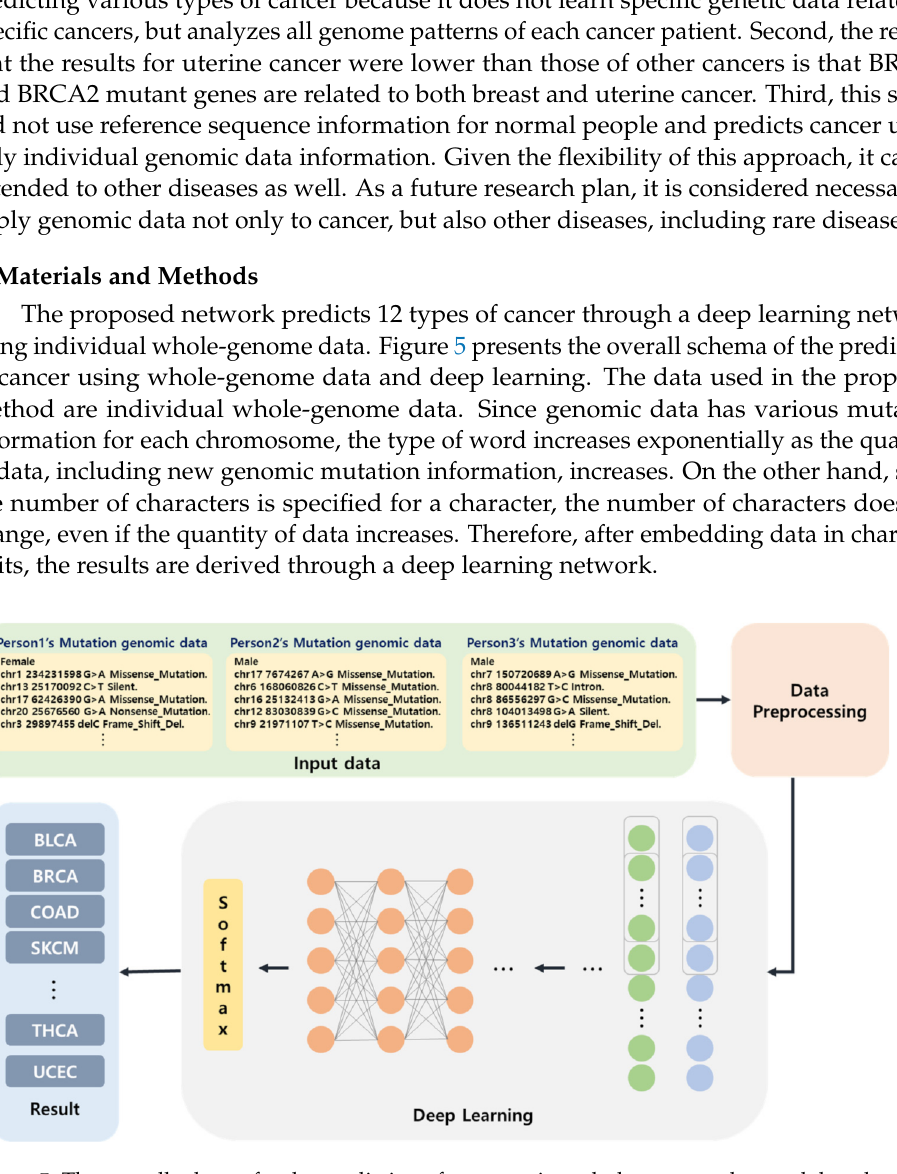
Figure 5. The overall schema for the prediction of cancer using whole-genome data and deep